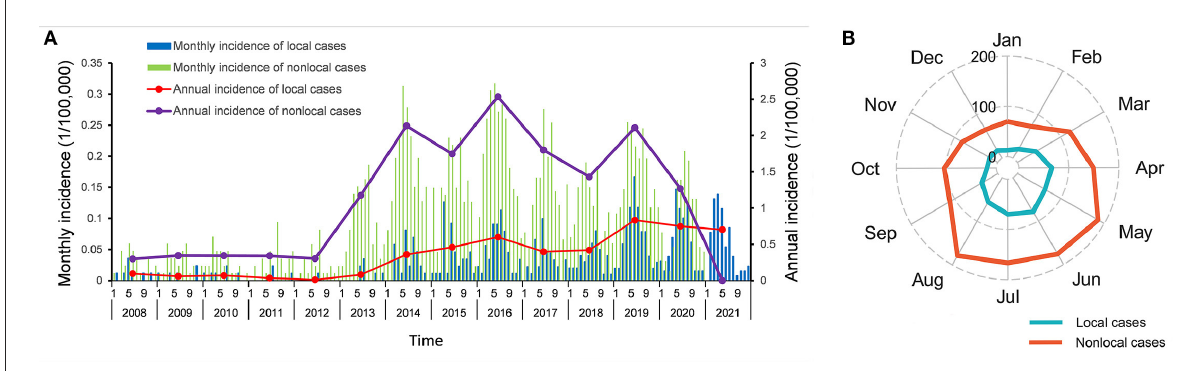
FIGURE1 Temporal distribution and seasonal trend of human brucellosis in Xi’an, 2008–2021. (A) Monthly and annual incidences of local and non-local cases. (B) Monthly number of local and non-local cases.